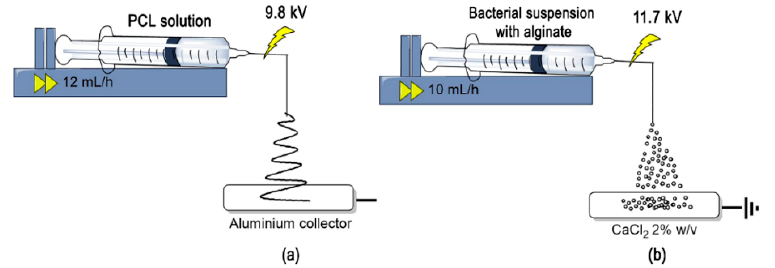
Figure 1. Representation of the electrohydrodynamic processing used to obtain ( a ) micro-fibrous mats of Polycaprolactone (PCL) and ( b ) microcapsules of alginate with L. sphaericus CBAM5 .